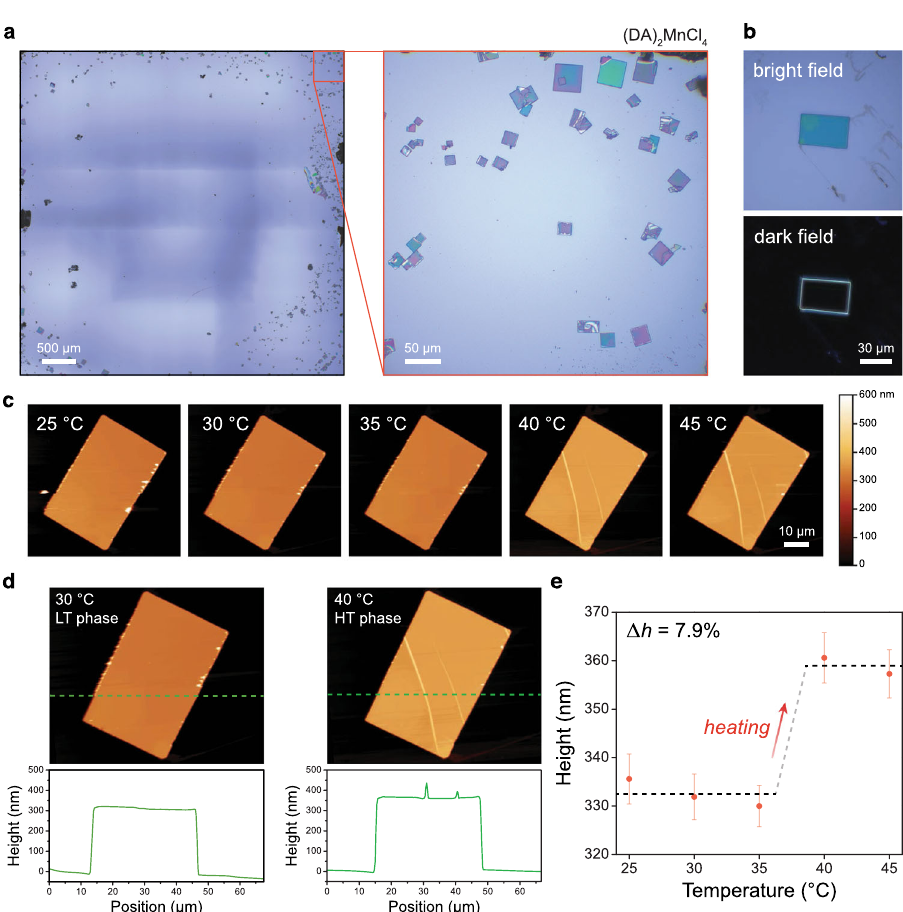
Fig. 9 Phase transition of single crystals on a substrate. a Optical images of (DA) 2 MnCl 4 single crystals directly grown on Si substrates through an anti- solvent vapor-assisted capping crystallization method. b Bright fi eld (top) and dark fi eld (bottom) images of a sub-micron thick single crystal. c Variable- temperature atomic force microscope (AFM) imaging experiments for a sub-micron thick (DA) 2 MnCl 4 single crystal. d Height pro fi les of a sub-micron thick (DA) 2 MnCl 4 single crystal in the low-temperature (LT, left) and high-temperature (HT, right) phases. e Thickness of a single crystal of (DA) 2 MnCl 4 as a function of temperature. The heating-induced transition from the LT phase to HT phase gives rise to an 7.9% change in height, which agrees well with the 7.4% predicted from crystallographic data obtained from variable-temperature PXRD experiments at 30 °C and 45 °C. Error bars were obtained from the mean square difference between all data points in the scan region and the fi tted step height. Thermal cycling AFM experiments are described in Supplementary Fig.